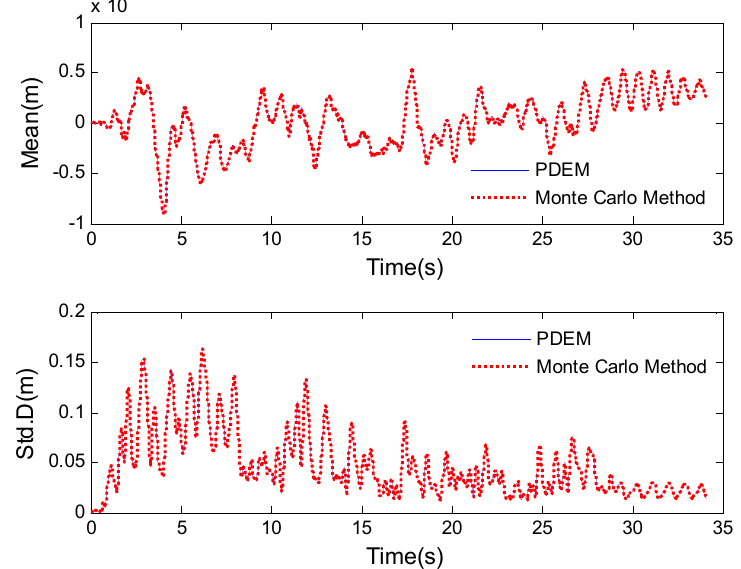
Figure 7. Mean and variance time histories of pile displacement.